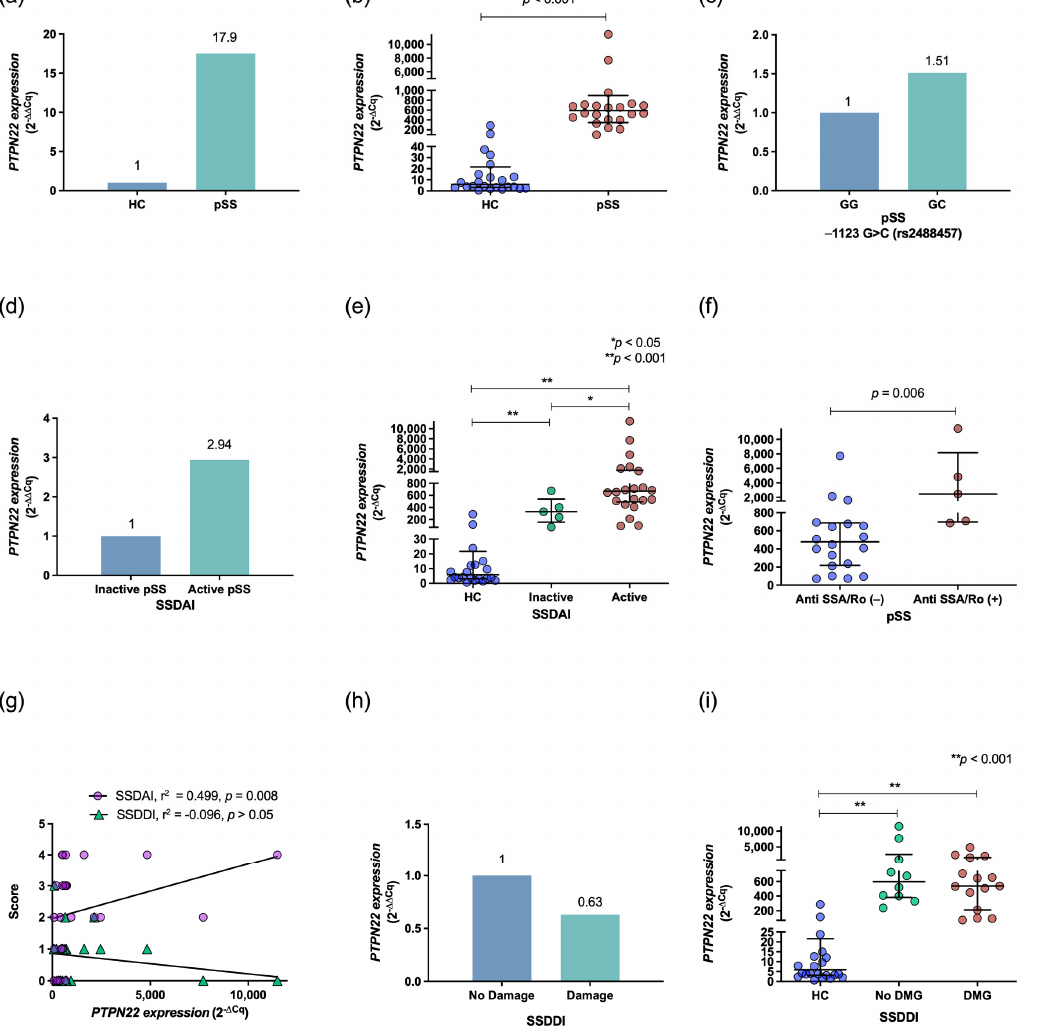
Figure 1. Association of PTPN22 expression with pSS, the rs2488457 ( − 1123 G>C) polymorphism, and clinical and histopathological indices. Expression was higher in pSS ( n = 28) than HCs ( n = 28) by both qualitative and quantitative methods (( a ) and ( b ), respectively). pSS patients with the rs2488457 ( − 1123 GC) ( n = 13) genotype showed 1.51 ‐ fold more mRNA expression than rs2488457 ( − 1123 GG) ( n = 15) carriers ( c ). Active pSS ( n = 22) was associated with higher PTPN22 expression by both qualitative and quantitative methods ( d , e ). pSS patients with anti ‐ SSA/Ro+ showed high PTPN22 mRNA expression ( f ). PTPN22 expression showed a positive correlation with SSDAI score ( g ). mRNA expression was lower in pSS patients with damage ( h , i ). Qualitative gene expression data are shown through the 2 −ΔΔ Cq method. Quantitative gene expression data are shown in REU obtained through the 2 −Δ Cq method. The p value was obtained through the Mann–Whitney U test or Kruskal–Wallis with Dunn’s post hoc test, as appropriate. Spearman’s rank correlation test was used. Data are shown as the median and IQR. DMG: damage, HC: healthy controls, IQR: interquar ‐ tile range, pSS: primary Sjögren’s syndrome, *: p < 0.05; **: p < 0.001.